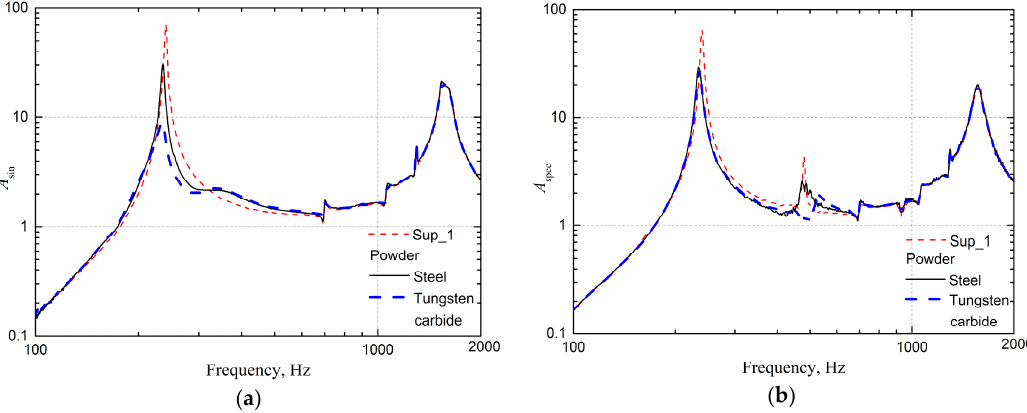
Figure 16. Experiment results of powder material: ( a ) Sinusoidal excitation; ( b ) Random excitation.